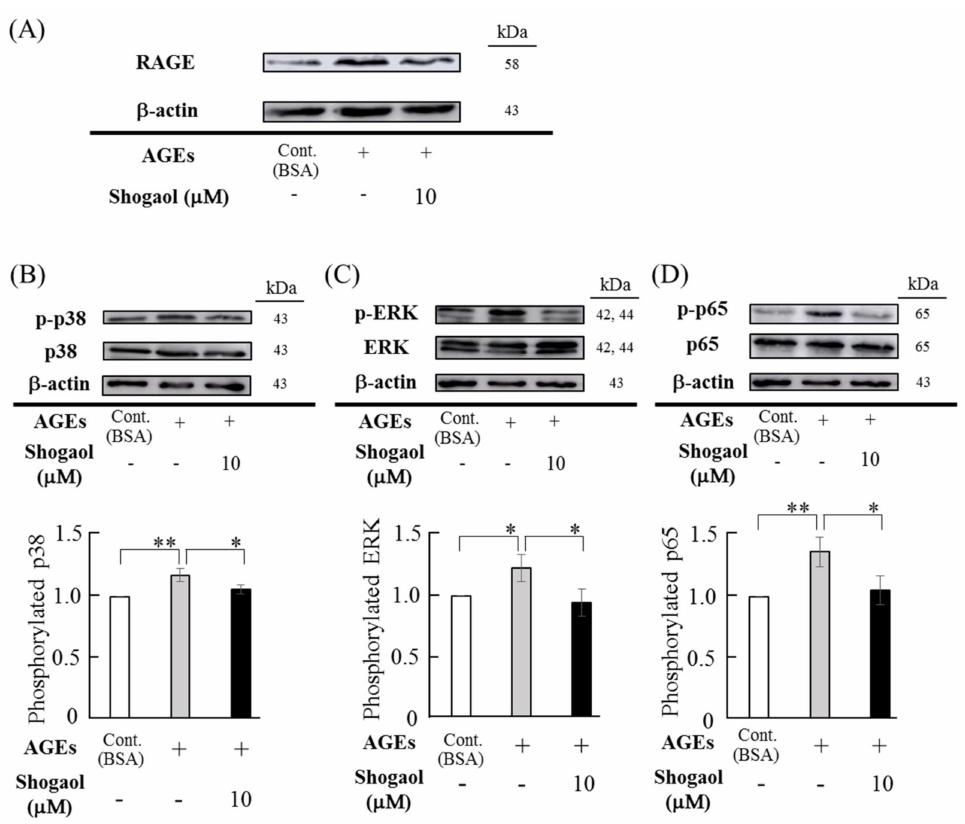
Figure 4. E ff ects of 6-shogaol on AGEs-induced RAGE expression and the activation of MAPK and NF- κ B signaling pathways. ( A ) Sub-confluent HGFs were cultured with AGEs (500 µ g / mL) or BSA (500 µ g / mL) for 24 h after pre-treatment with 6-shogaol (10 µ M) for 1 h. Cell lysates were used for western blotting for RAGE as described in the Materials and Methods section. ( B – D ) Sub-confluent HGFs were pre-treated with 6-shogaol (10 µ M) and then stimulated with AGEs (500 µ g / mL) or BSA (500 µ g / mL) for 30 min. Cell lysates were analyzed by western blotting using antibodies against MAPKs (p38, phospho-p38, ERK and phospho-ERK) ( B , C ) and NF- κ B (p65 and phospho-p65) ( D ) as described in the Materials and Methods section. Data are expressed as the mean ± SD of 3 independent experiments. The density of signal bands was determined by densitometric analysis and normalized